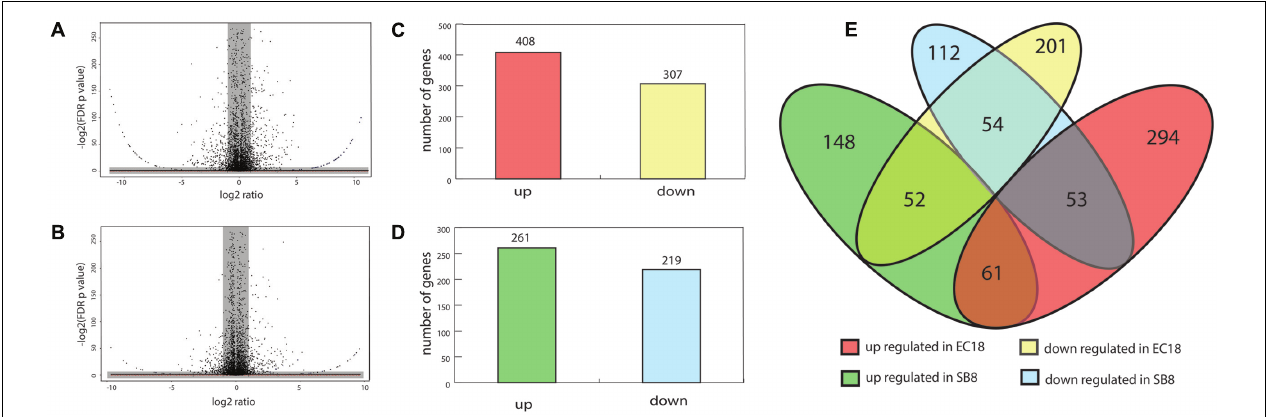
FIGURE 3 | Analyses of differentially expressed genes (DEGs) of B. mycoides in response to potato root exudates. (A,B) Volcano diagrams of DEGs of EC18 and SB8. Spots in the right and left quadrant indicate significantly up and down regulated genes, respectively. Spots in the gray area were neither over- or under-expressed genes. (C,D) The number of up and downregulated DEGs of B. mycoides EC18 and SB8. (E) Venn diagram showing the numbers of overlapped and non-overlapped